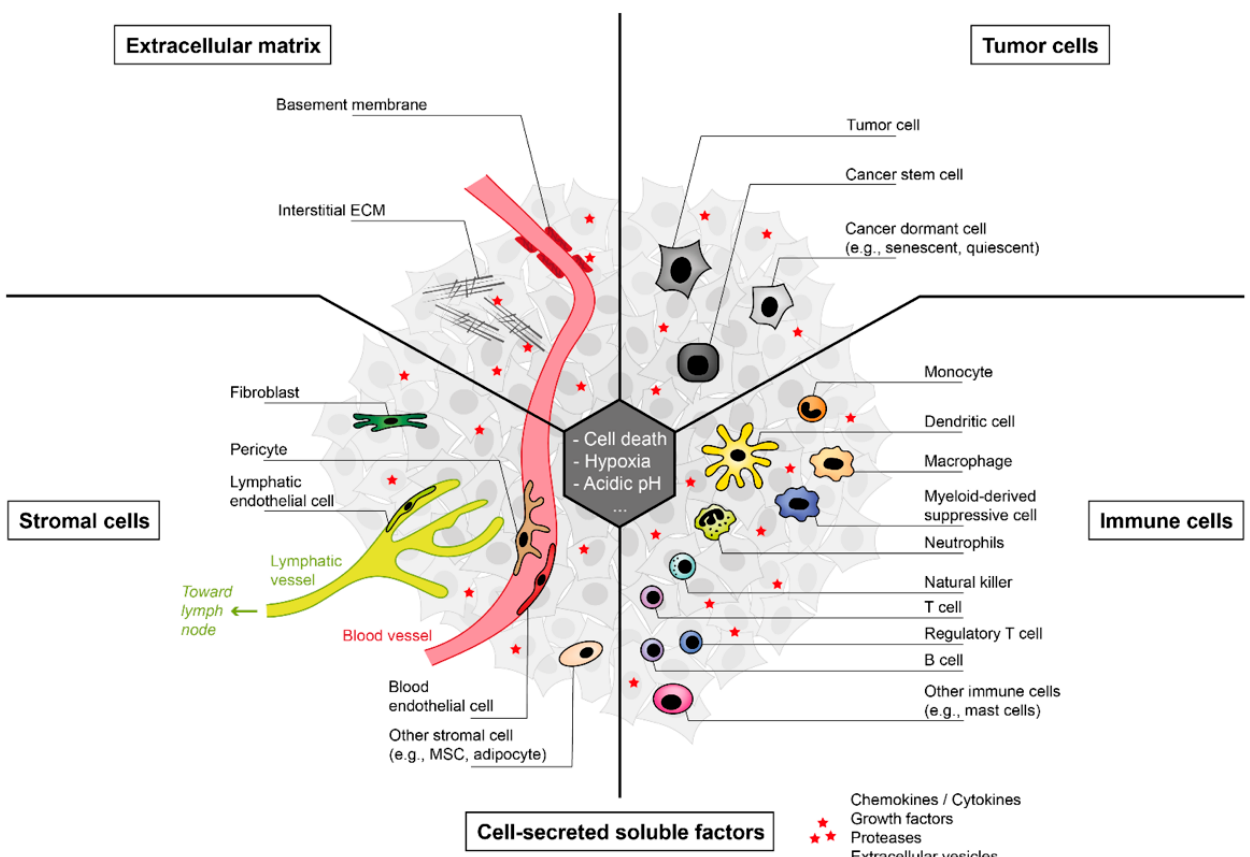
Figure 2. Overview of the components of the tumor microenvironment (TME). The cellular composition of the TME is quite heterogeneous and consists of various cell types. These include (i) tumor cells (upper right) as well as (ii) stromal cells (lower left) and (iii) immune cells (lower right). Soluble factors secreted by the cells of the TME (red stars) also play an important role, as do structural components, such as (iv) the extracellular matrix (ECM; upper right).